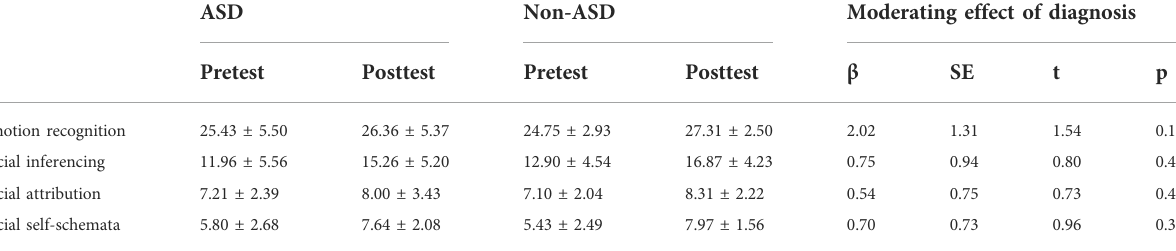
TABLE 5 Comparison of ASD vs non-ASD participant training outcomes on four measures of social cognition. ASD Non-ASD Moderating effect of diagnosis Pretest Posttest Pretest Posttest β SE t